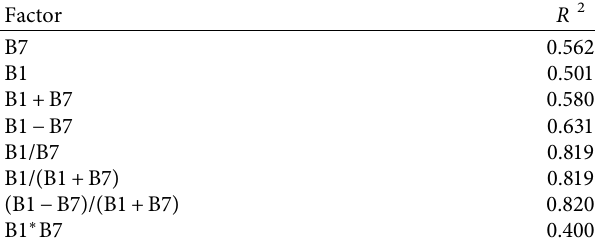
Table 3: Correlation index between DO and band.